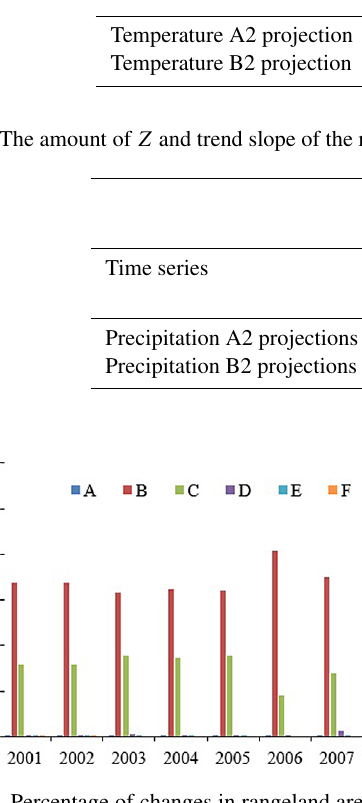
Figure 4. Percentage of changes in rangeland area or the deviation from the long-term average of NPP. 0–40 C, 40–80 D, 80–120 E, 120–160 F and 160<are related to a positive amount; classes of − 40–0 B and < − 40 A are related to the amounts of decrease com- pared to the long-term average.